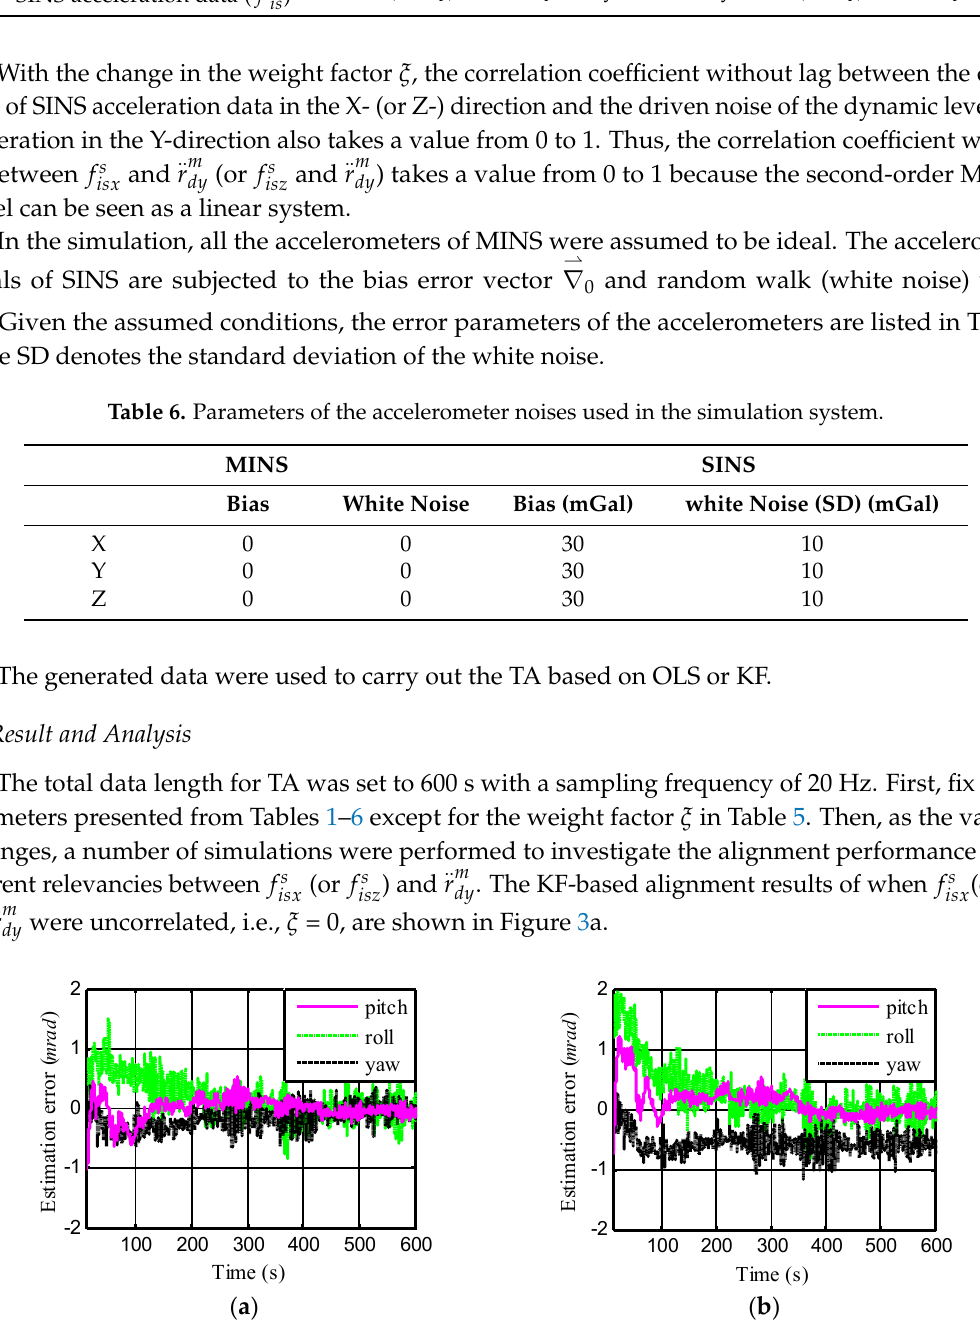
Figure 3 . Alignment error using Kalman filtering (KF) for different correlation between the SINS acceleration data in X (or Z)-direction and the dynamic lever-arm acceleration in Y-direction: ( a ) Uncorrelated ( b ) Partly correlated.